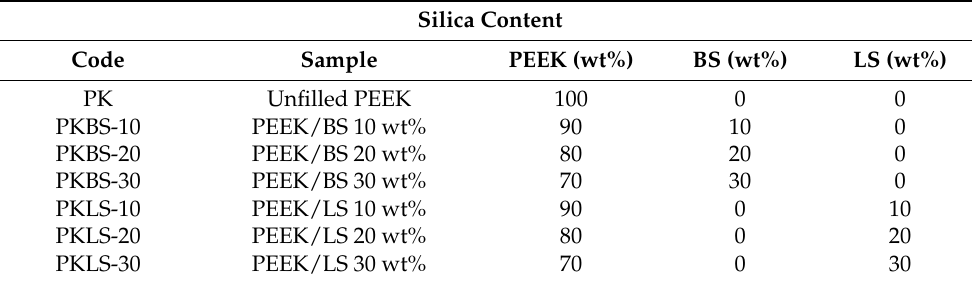
Table 1. PEEK/SiO 2 nanocomposites formulations (percentage by